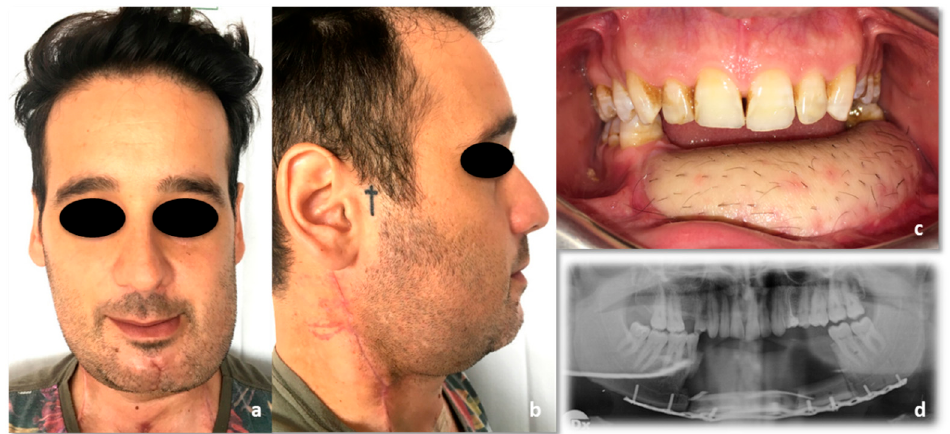
Figure 11. Forty-five-days post-operative condition. ( a ) Frontal view; ( b ) side view; ( c ) intraoral picture; ( d ) Rx orthopantomography.